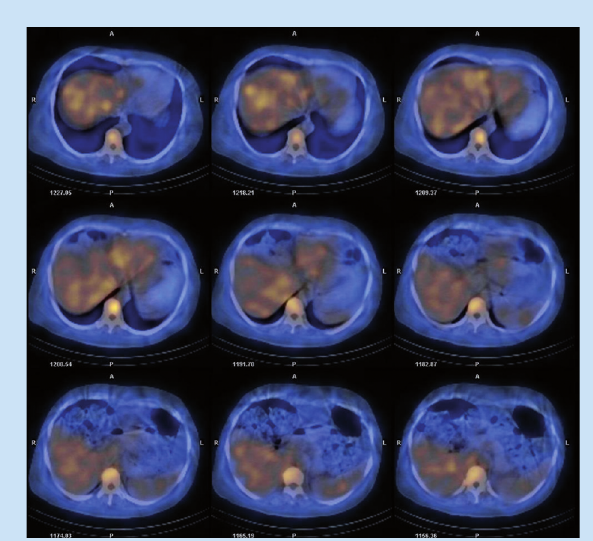
Fig. 3. Fused anatomical and functional images confirming the findings on SPECT and CT of the abdomen.